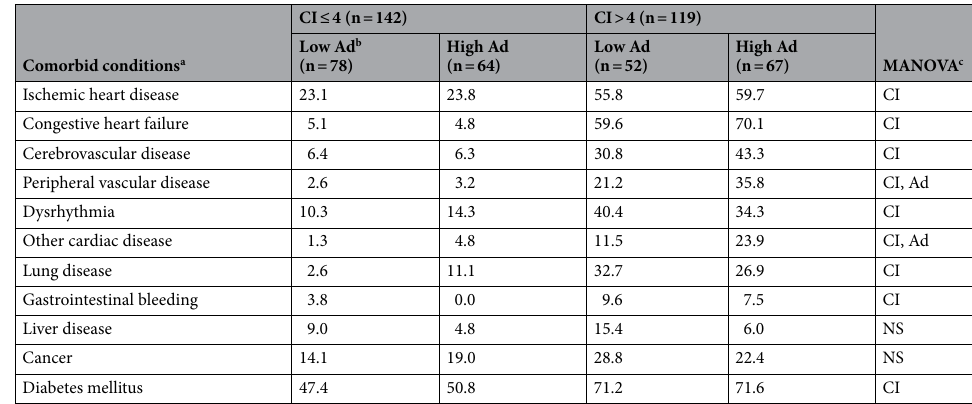
Table 2. Prevalence (%) of comorbid conditions at baseline in the study population (n = 261), grouped according to comorbidity index and serum adiponectin (mcg/ml) levels. CI, comorbidity index; NS, non- significant; Ad, adiponectin. a See Methods for definitions of comorbid conditions. b Low adiponectin was defined as adiponectin < 8.28mcg/ml, the valuebelow the medianof distribution. c Two-factor MANOVA. Significant ( p < 0.05) effects are given for comorbidity index (CI), adiponectin (Ad), and the interaction of comorbidity index with adiponectin (CI × Ad).